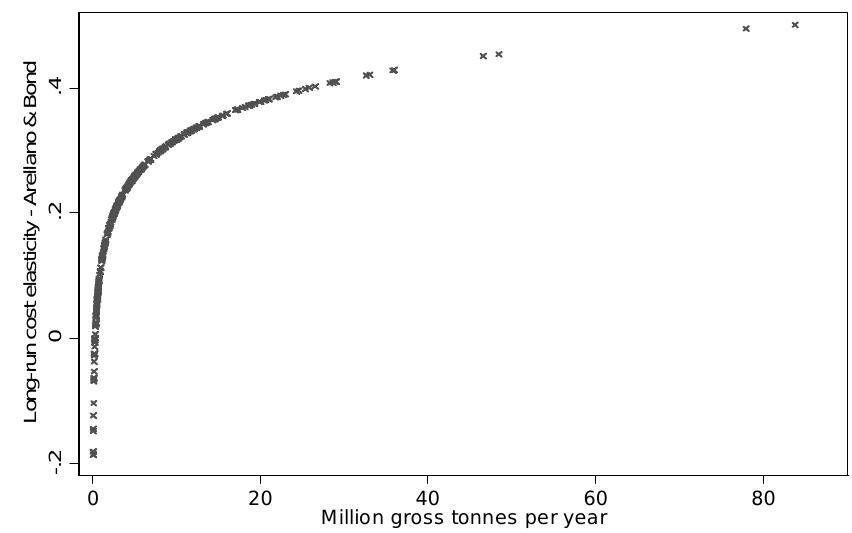
Figure 3. Long-run maintenance cost elasticity with respect to output – Model IIIa To predict costs and calculate marginal costs from Model IIIa , we need to look at the actual model that is